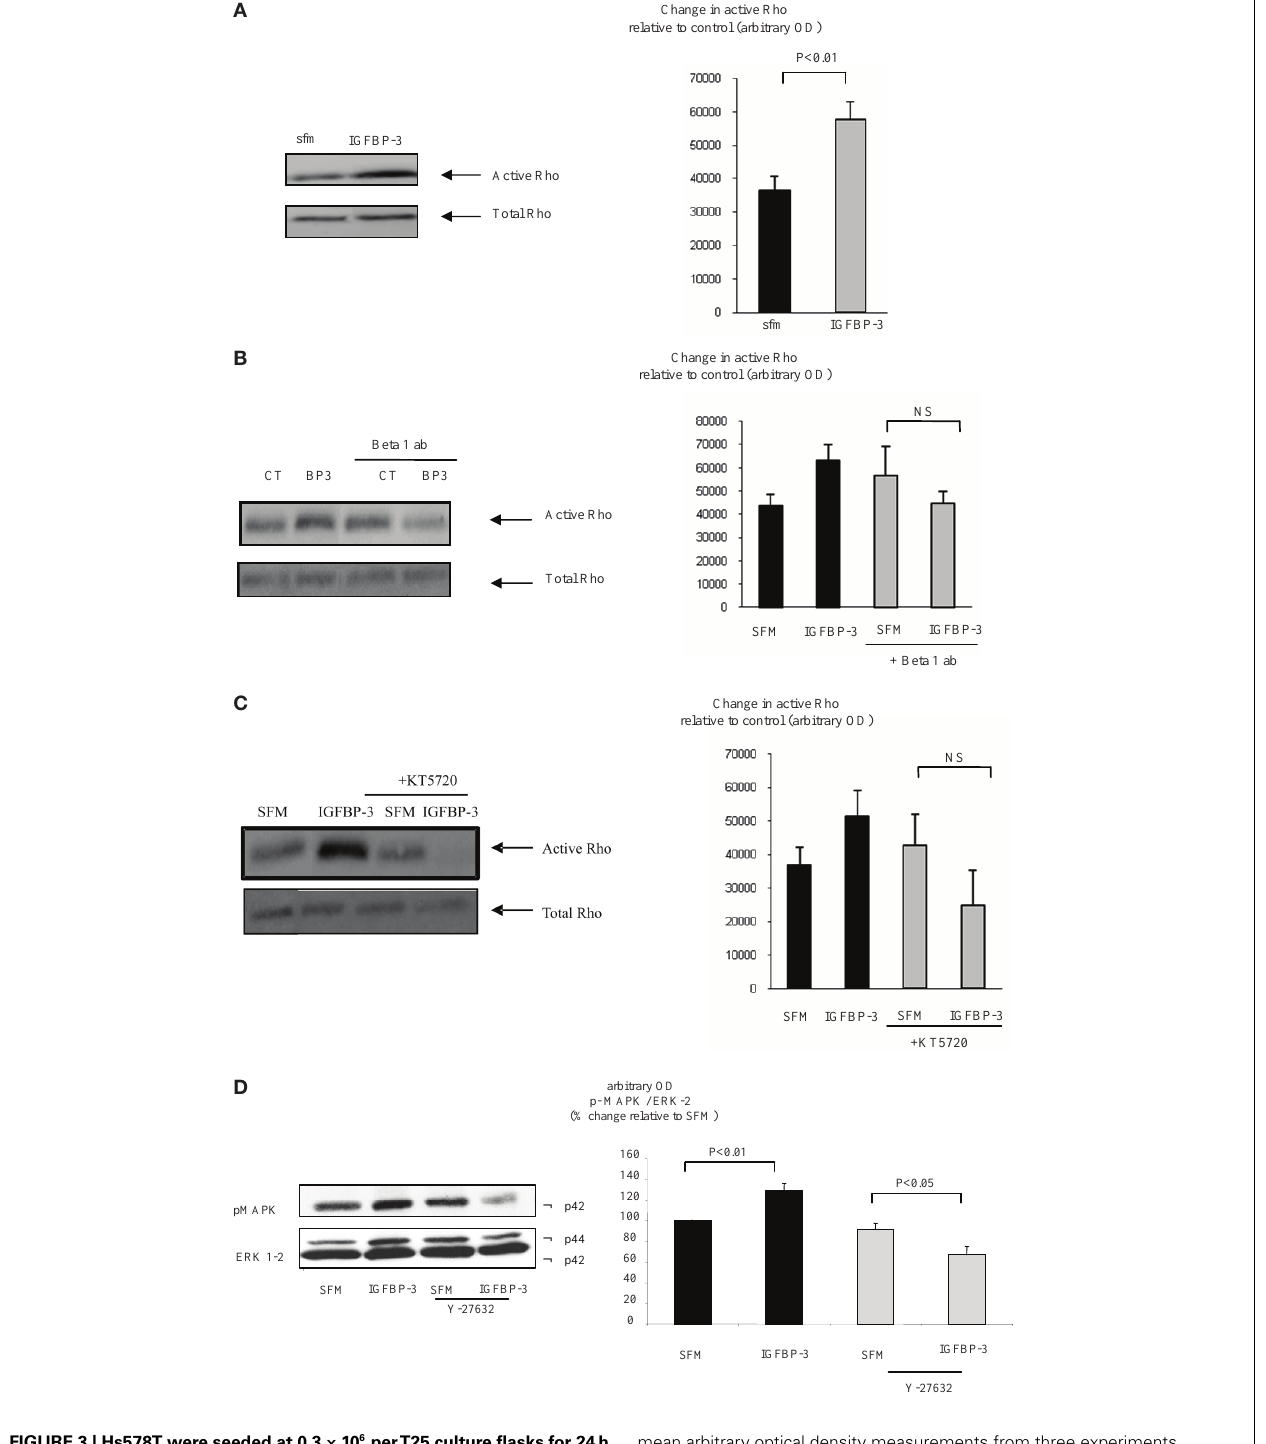
mean arbitrary optical density measurements from three experiments demonstrating the change in active Rho compared to the control. (D) Cells were treated with IGFBP-3 (100ng/ml) for 30min following a 30-min pre-dose withY-27632 (5 μ M) and showsWestern immunoblots of p-MAPK and total ERK-2 and are representative of experiments repeated three times.The graph shows the mean arbitrary optical density measurements from three experiments demonstrating changes in p-MAPK corrected for